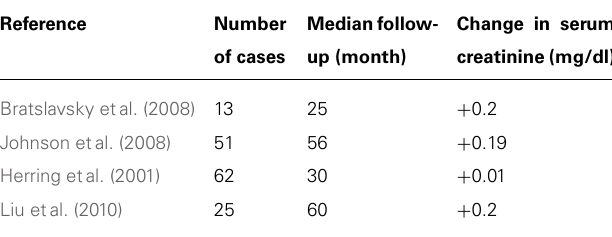
Table 3 | Functional outcomes post-nephron-sparing techniques in hereditary multifocal